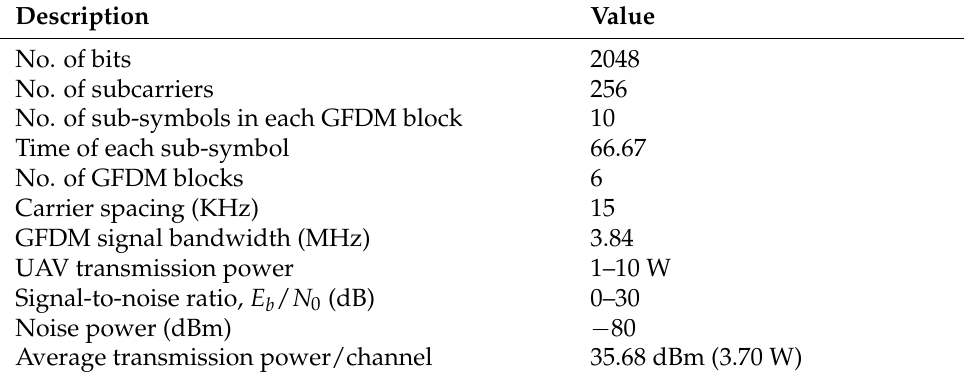
Table 1. Simulation